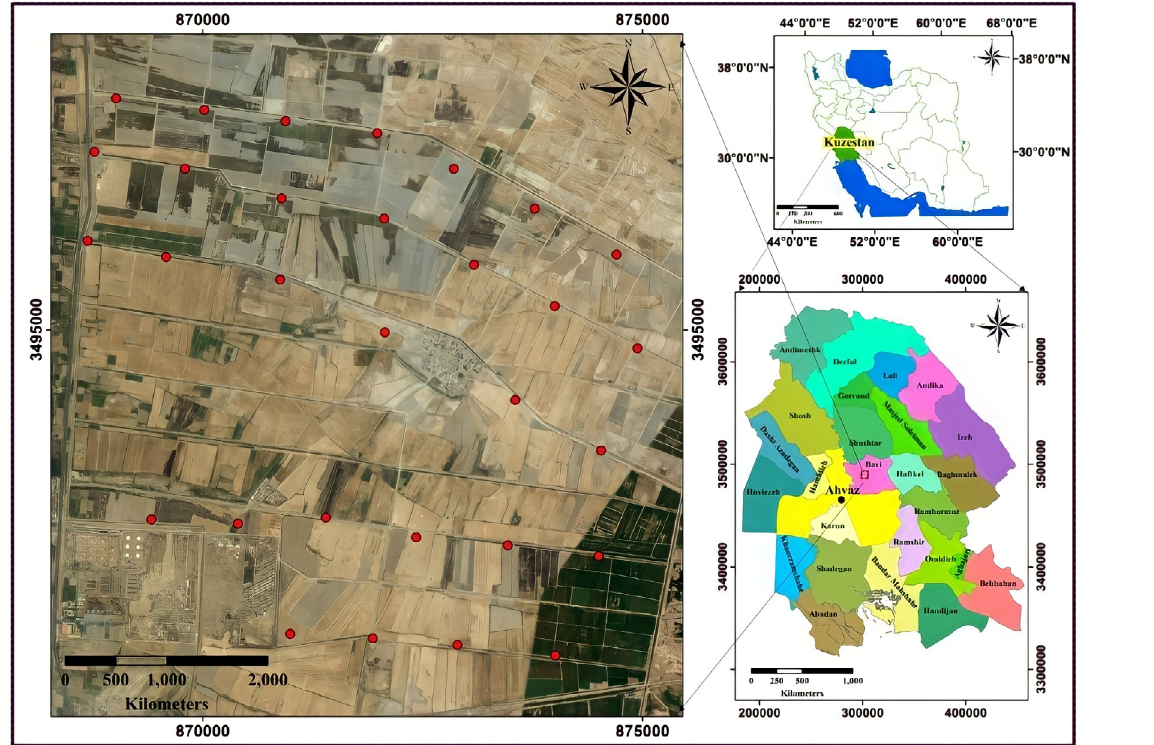
Figure 1. Geographical location of the sampling site of the Arab Assad